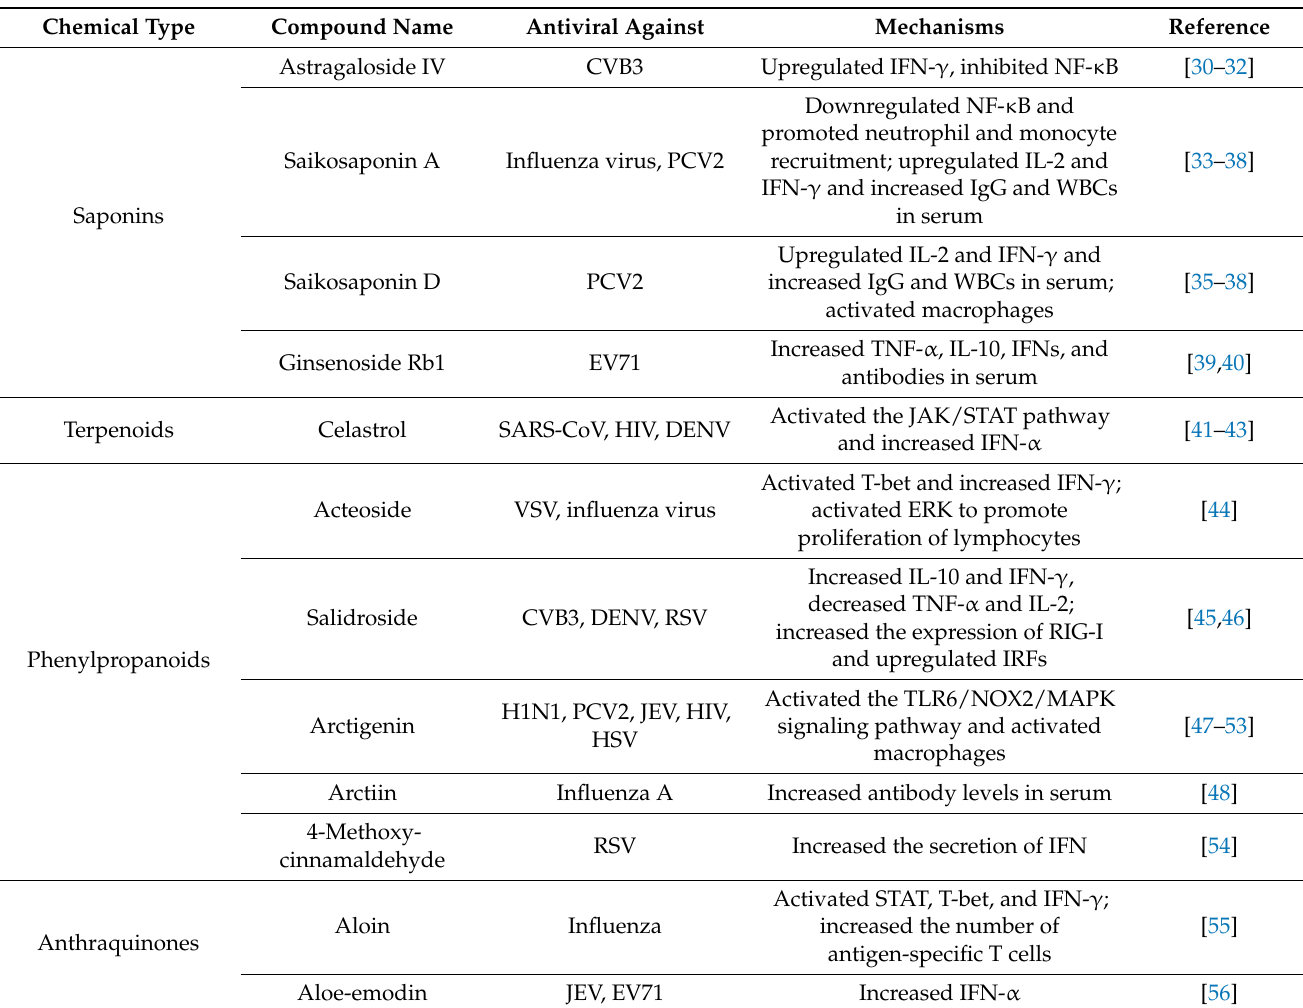
Table 1. Antiviral effects of natural immunomodulatory products.